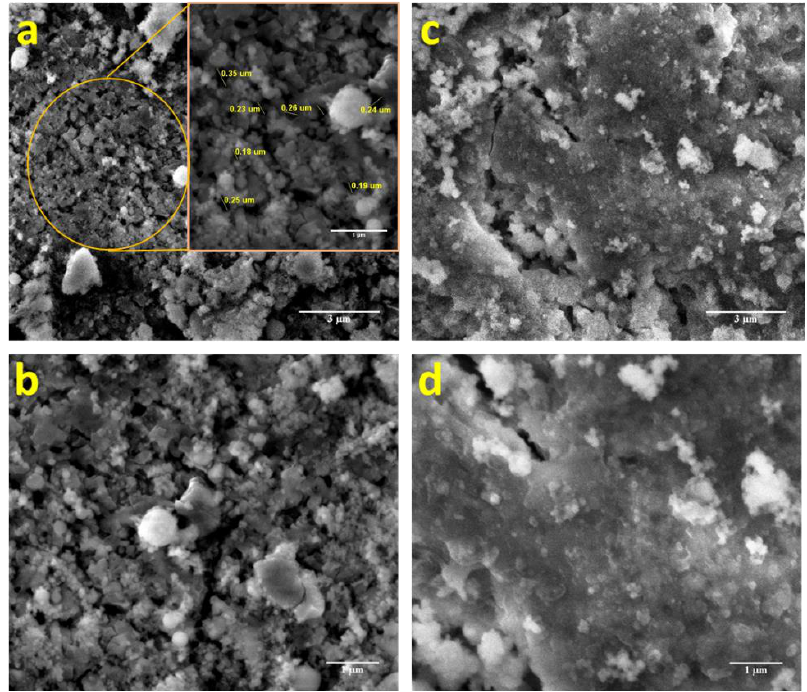
Figure 12. SEM image of bioglass tablet (a) before immersion; (b) after 1 week immersion; (c) after 2 week immersion and